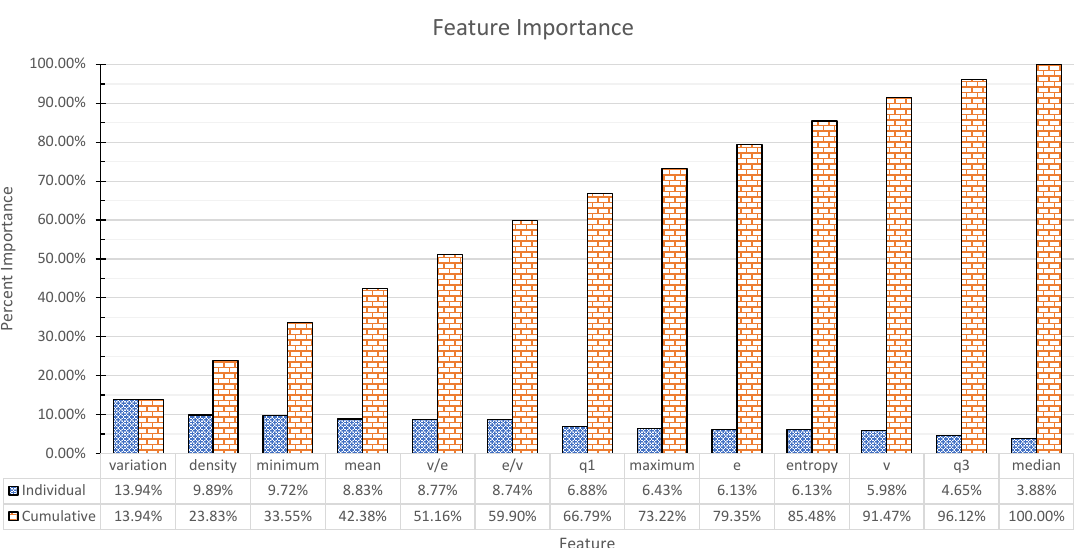
Figure 2. Feature importance for the Random Forest model trained on Dataset B (Section 4.2). We refer the reader to Section 3.1 for the list of features used. Each bar indicates the fraction of impurity in the dataset that is removed by splits on the relevant feature in all trees of the